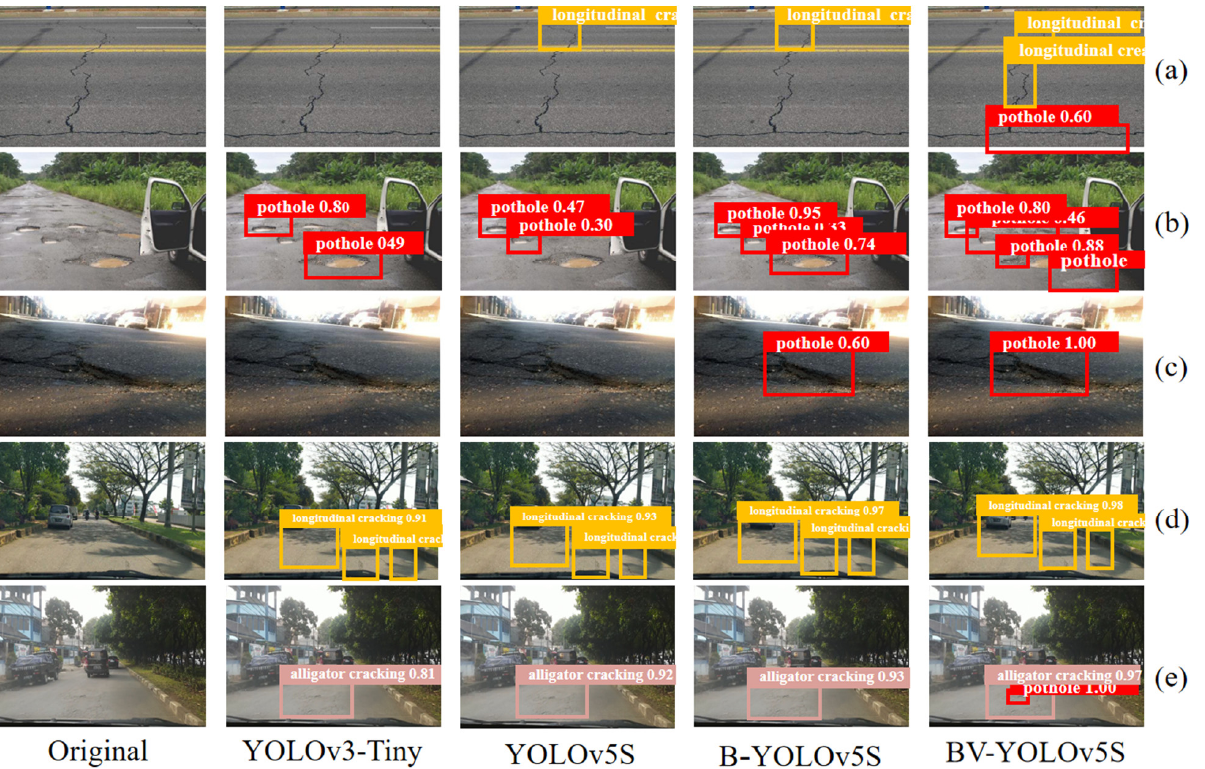
Figure 9. The test results of different network models in a complex environment. ( a ) The model detection results of four types of pavement defects in a rutting interference environment. ( b ) Detection results of four types of pavement defect models under the conditions of many and small targets. ( c ) The detection results of the four types of pavement defect models under environments of uneven illumination intensity. ( d ) The model detection results of four types of pavement defects under partial shadow occlusion conditions. ( e ) Alligator crack detection in the presence of small target potholes.